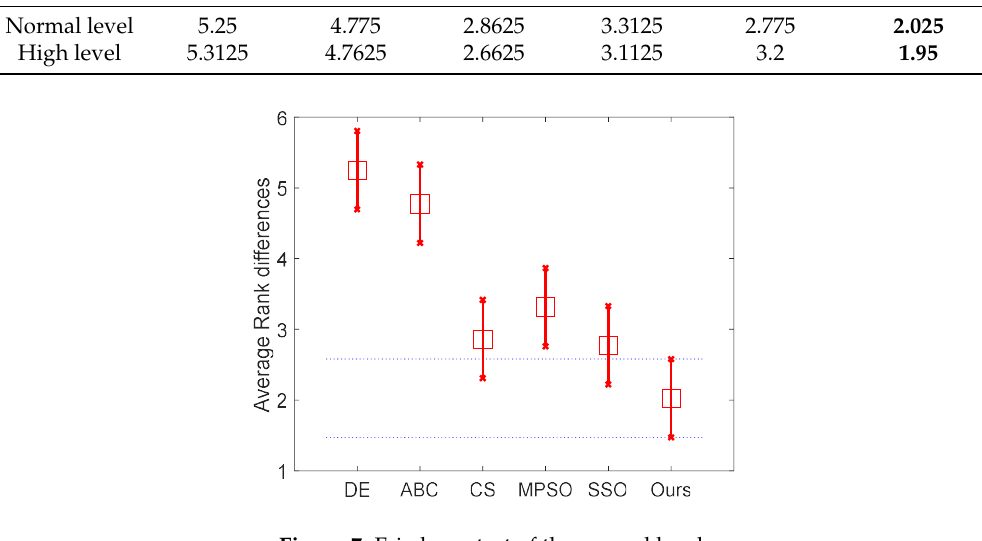
Table 8. Numerical rankings of the Friedman tests.